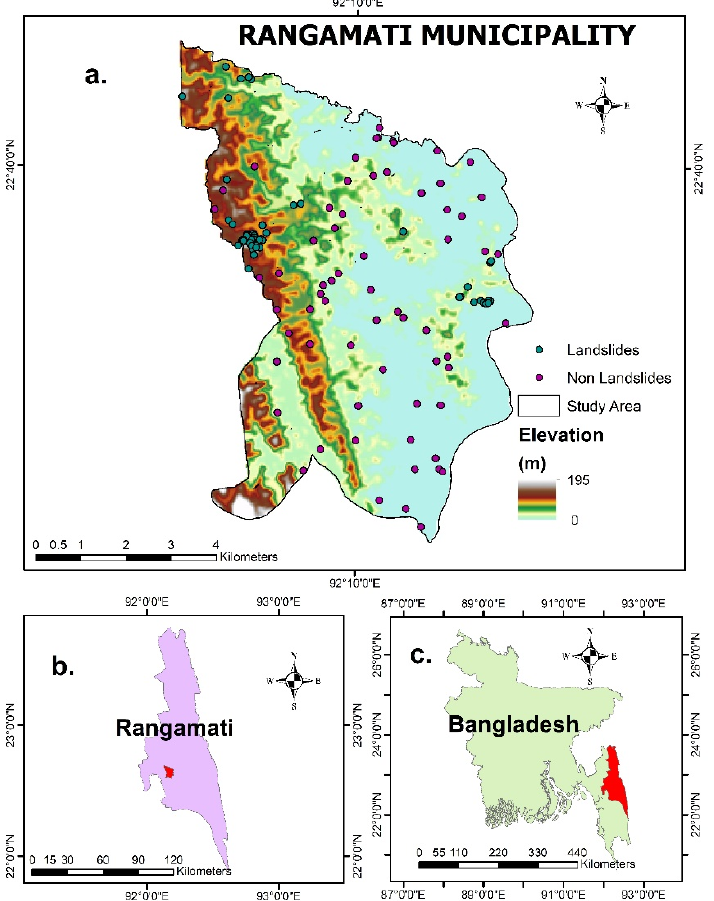
Figure 1. Location of Rangamati municipality in Rangamati district, Bangladesh: ( a ) Rangamati Municipality; ( b ) Location of Rangamati Municipality in Rangamati District; ( c ) Location of Rangamati District in Bangladesh.